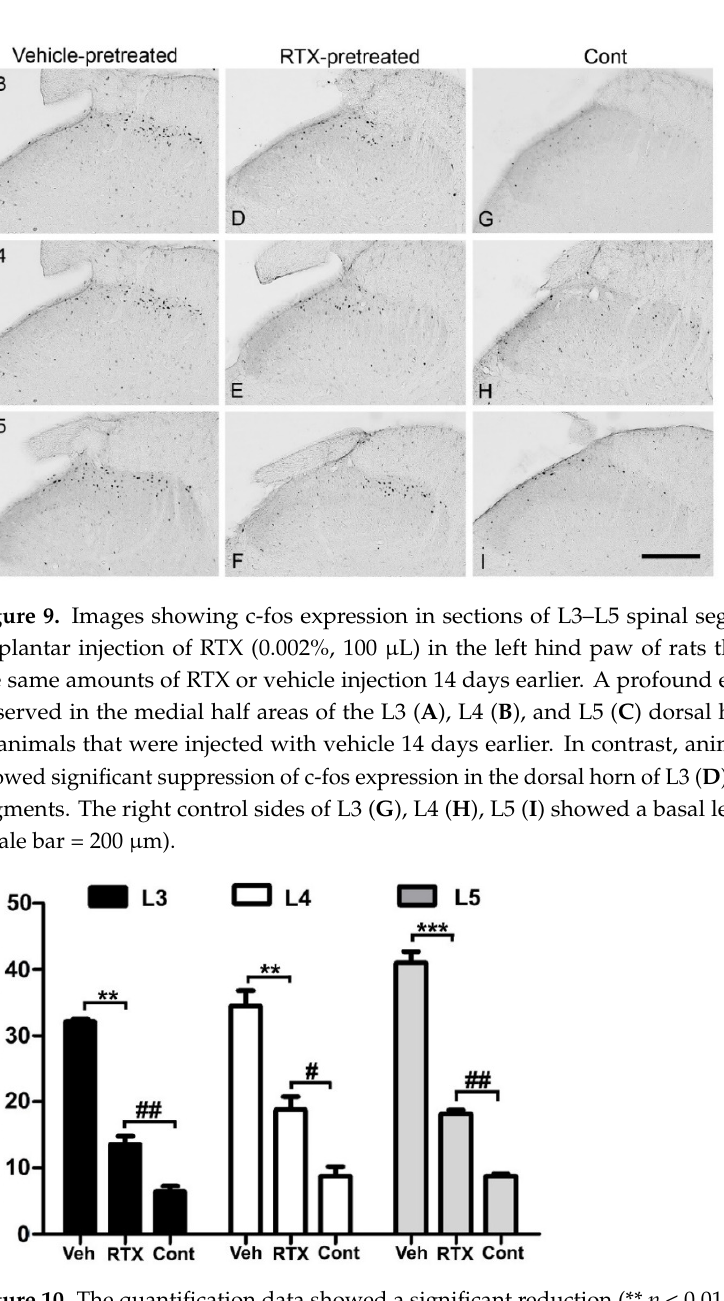
Figure 10. The quantification data showed a significant reduction (** p < 0.01; *** p < 0.001, One-way ANOVA) in the number of c-fos labelled neurons in the L3, L4 and L5 spinal segments of RTX-injected rats compared to the vehicle-injected rats. However, significantly more c-fos expression was observed in the RTX-injected rats compared with control right sides of L3, L4, and L5 segments [(# p < 0.05, ## p < 0.01) n = 3–4].